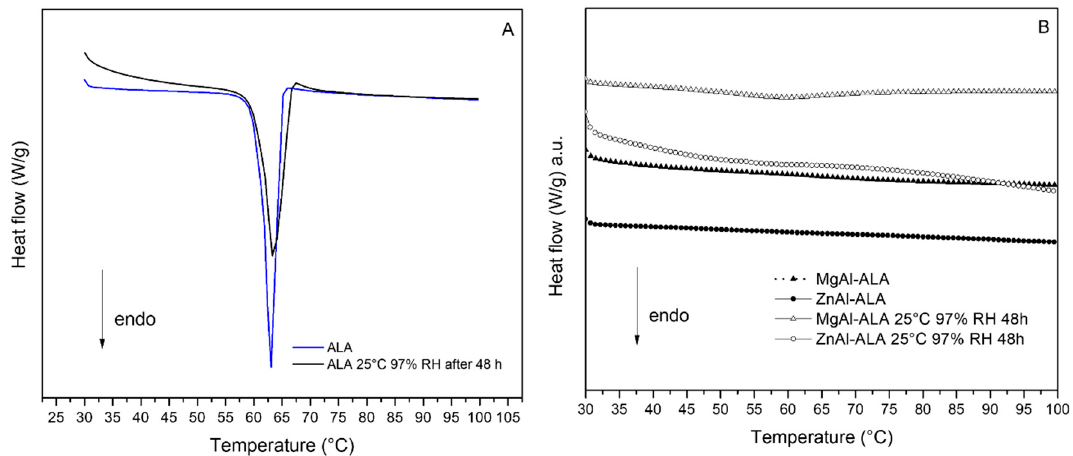
Figure 3. Thermograms obtained before and after storage at 25 °C for 48 h 97% RH of: ( A ) crystalline ALA; ( B ) MgAl-ALA and ZnAl-ALA, the spectra (B) are shown in arbitrary units (a.u.) and shifted for clarity.